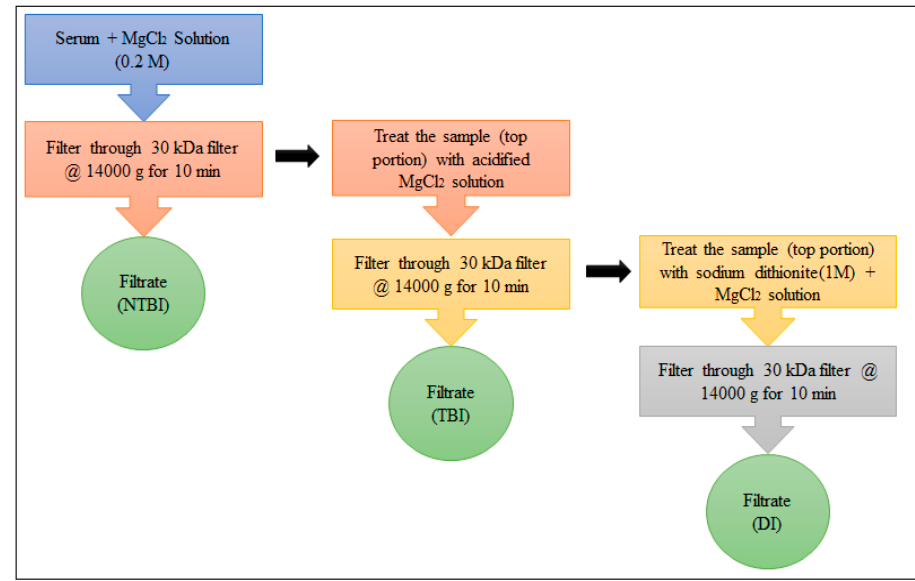
Figure 1. Detailed methodology of ultra-filtration procedure.